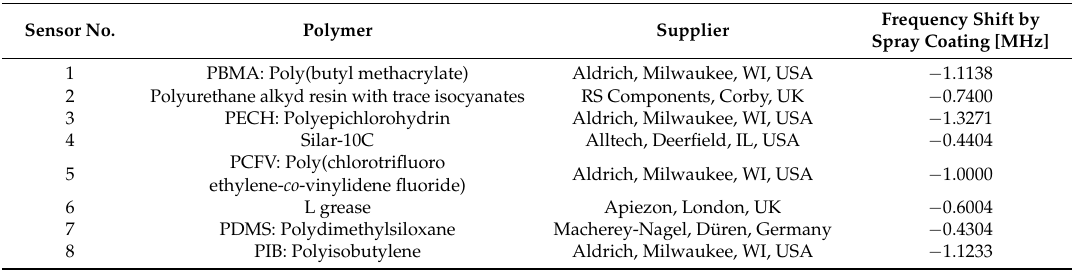
Table 1. Polymer coatings of STW resonators, f 0 = 433 MHz, used as VOC sensors. Sensor No.